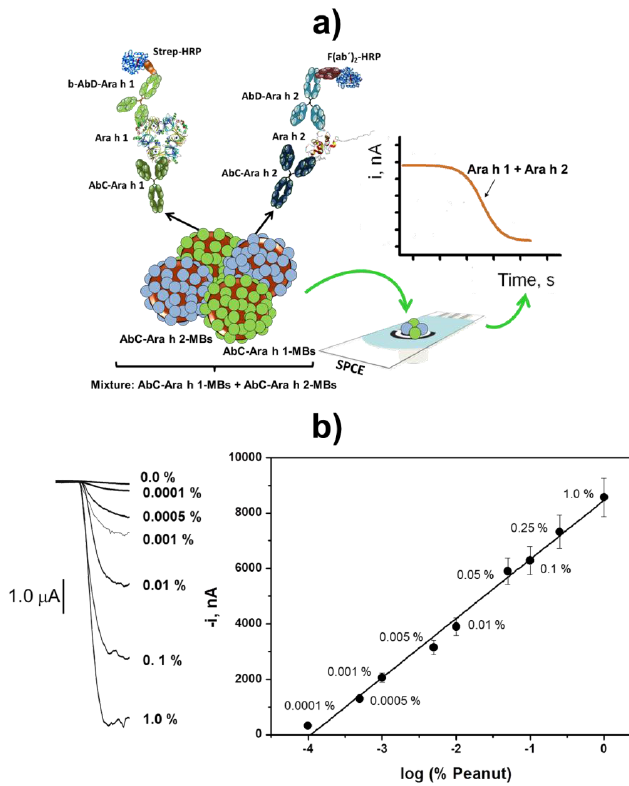
Table S1: Optimized experimental variables affecting the performance of the electrochemical dual MBs-based immunosensing platform for the simultaneous determination of Ara h 1 and Ara h 2, Figure S1: ( a ) Current values measured with the dual immunosensing platform from extracts prepared with unspiked and spiked with 0.5 (Ara h 1) and 0.005 (Ara h 2) % ( w / w ) wheat flour using different sample treatments: protocol described in Section 2.4 (1); centrifugation steps were substituted by a 30-min natural decantation process (2); centrifugation steps were omitted (3). ( b ) Real picture of the extracts obtained after applying each sample treatment. Supporting electrolyte, 0.05 M sodium phosphate solution, pH 6.0; E app = ´ 0.20 V vs. Ag pseudo-reference electrode. Error bars estimated as triple of the standard deviation ( n =